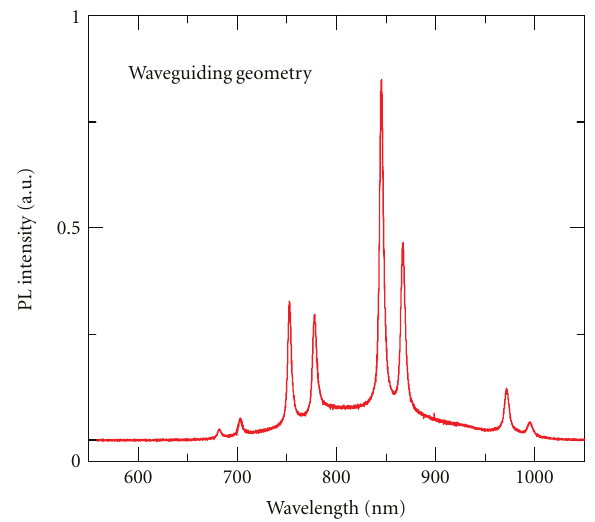
Figure 6: PL from a SiO x film measured in the waveguiding geometry, that is, along the surface from the film edge [100].